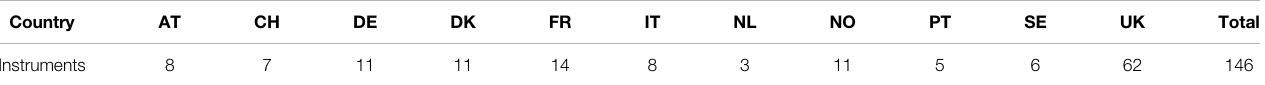
TABLE 1 | Total instruments included in the analysis by